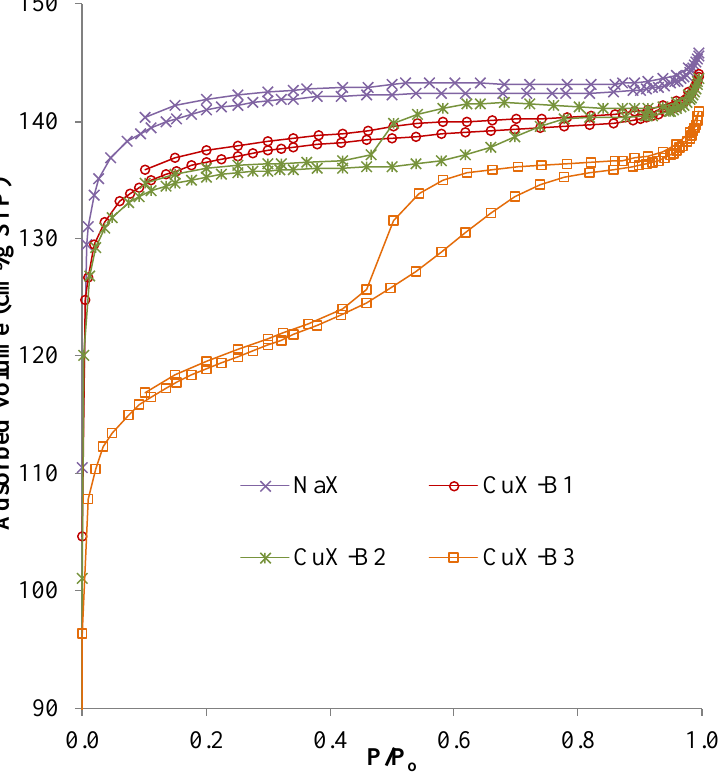
Figure 3. Adsorption-desorption isotherms of the NaX and copper-exchanged